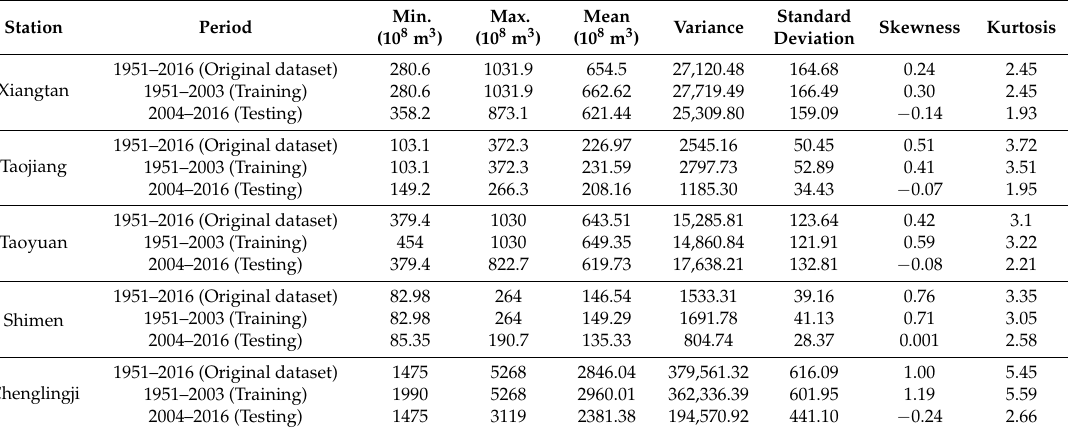
Table 1. Statistics of annual runoff time